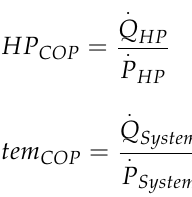
Figure 9. Comparison of optimization results; ( a ) comparison result between the existing design method and the optimized design method for the heating and cooling capacity of heat pumps, ( b ) comparison result between the existing design method and the optimized design method for the volume of the heat storage tank